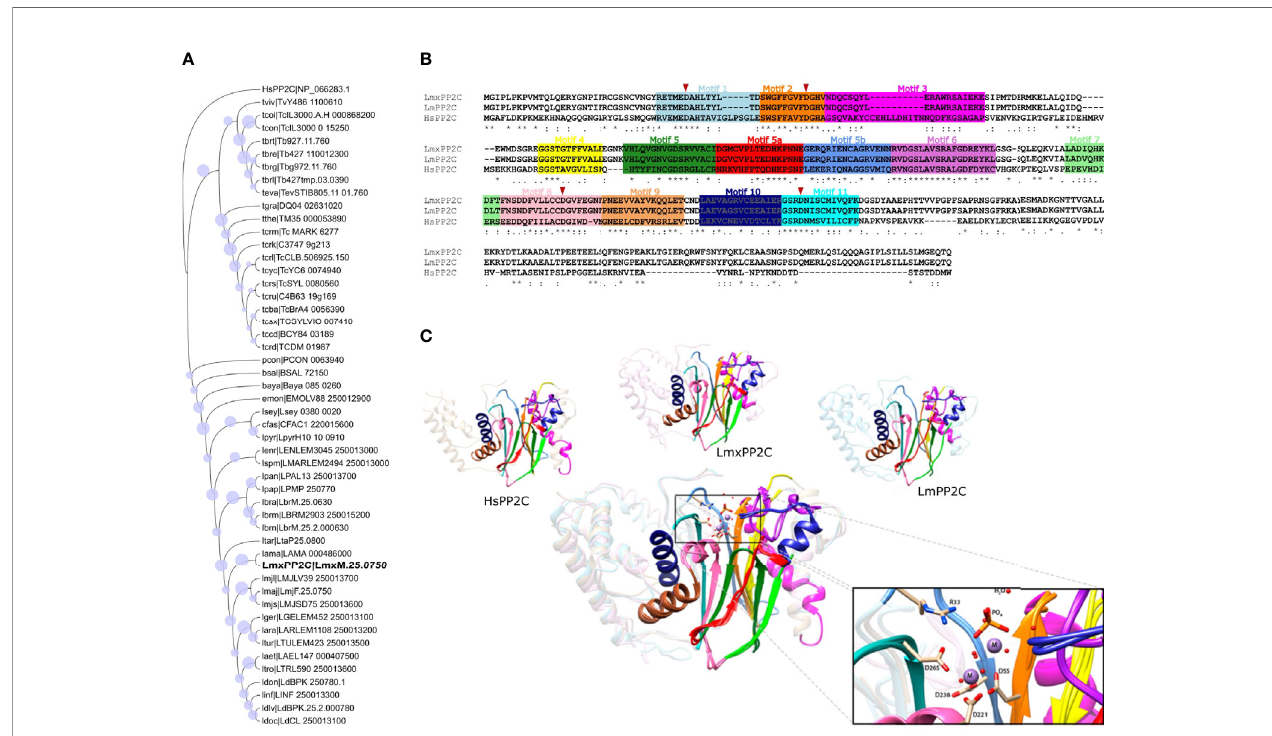
FIGURE 5 | Phylogenetic tree, multiple sequence alignment and structural alignment of Leishmania PP2C. (A) Analysis of the phylogenetic tree of Leishmania PP2C, fi nding that they belong to the ortholog group OG6_142542 (using the maximum likelihood method based on the LG+G+I model). The analysis involved 50 amino acid sequences. Bootstrap values for each node are shown as a circle. (B) Multiple sequence alignment of L. mexicana, L. major and human PP2C ( Lmx M.25.0750, Lm F.25.0750 and NP_066283.1, respectively). The 11 conserved motifs are indicated by colored boxes with their corresponding motif numbers in the upper part of the fi gure. The four aspartates implicated in the catalytic mechanism are conserved in each sequence (red arrowhead). (C) Structural alignment of the predicted Lmx PP2C, Lm PP2C and HsPP2C (1A6Q) carried out on the USCF Chimera program. The 11 conserved motifs of the PP2C catalytic domain are depicted in cartoon representation with distinct colors for each conserved motif. The amino acids participating in the catalysis are portrayed as sticks, while the rest of the protein is illustrated in the background. The structural alignment demonstrates conservation between PP2C